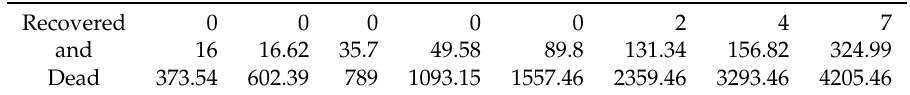
Table 4. Cumulative sum of the addition of the recovered individuals and the dead (natural order from left to